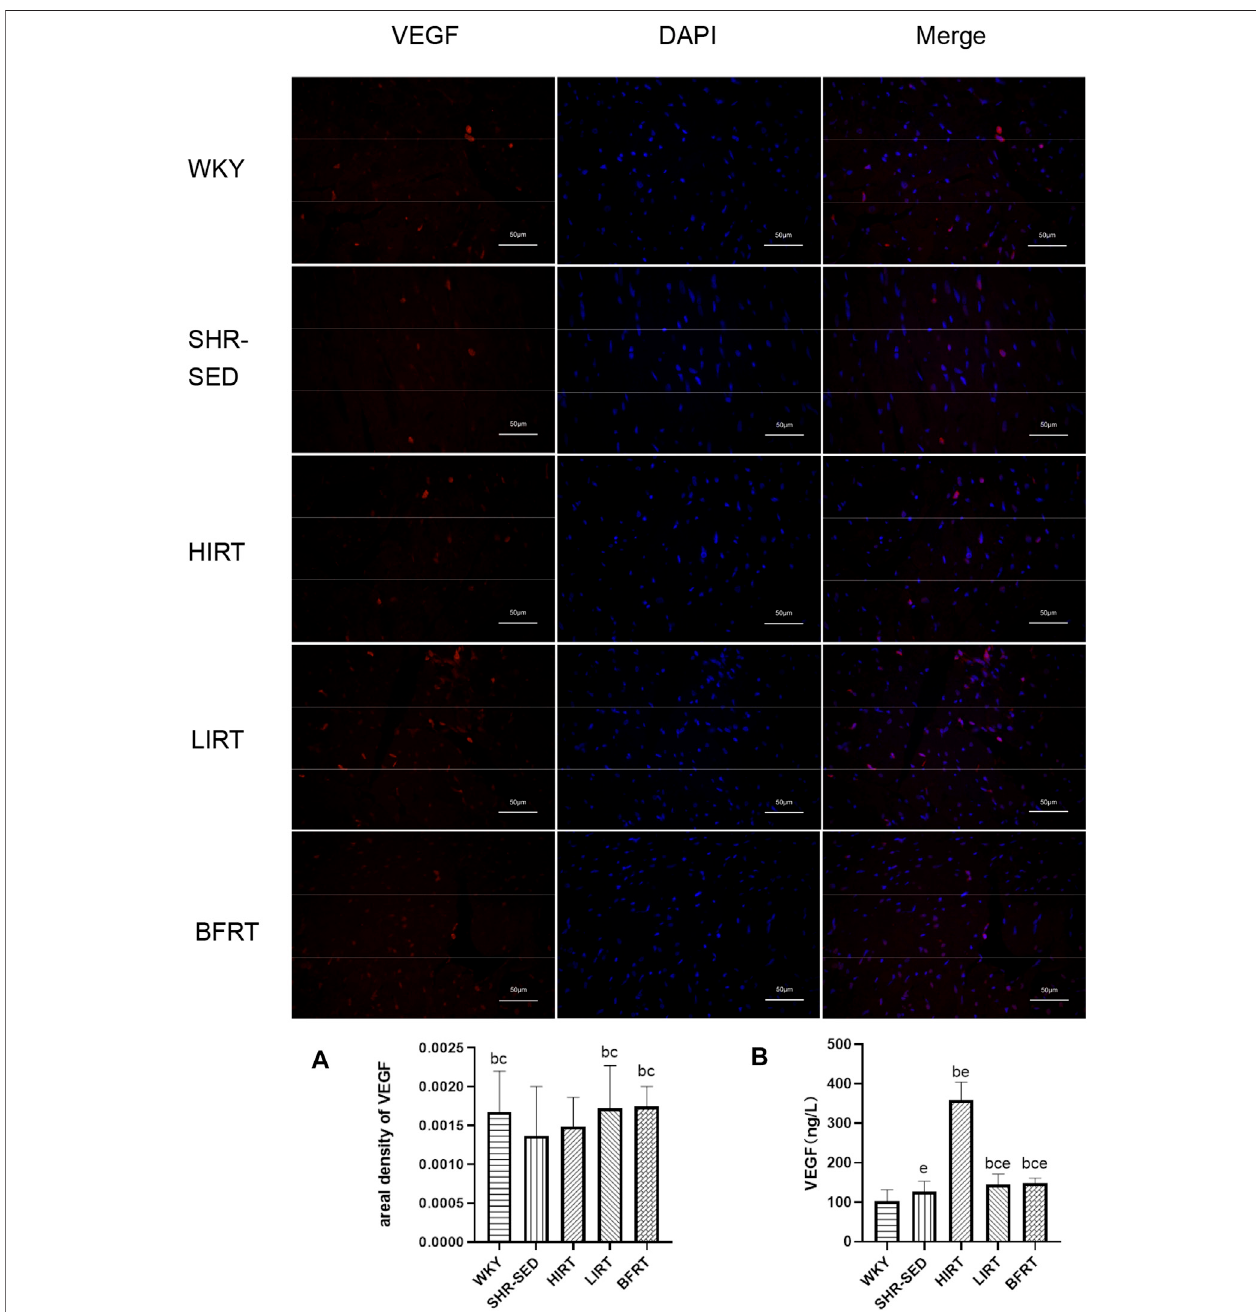
FIGURE 4 | (A) Immuno fl uorescence fi ndings of VEGF in left ventricular tissues. Nucleus is blue by labeling with DAPI. Positive cells are red according to the fl uorescent labels used. All the pictures were taken at ×200 magni fi cation, Scale bars, 50 μ m. The greater the areal density value, the higher the VEGF fl uorescence intensity. (B) VEGF protein expression in